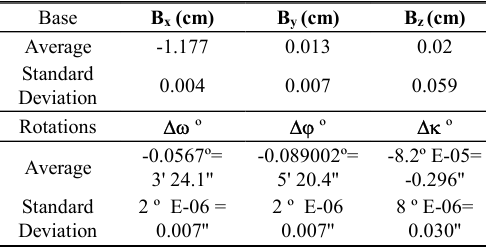
Table 8. Average values and standard deviation of the average for the relative orientation elements in experiment